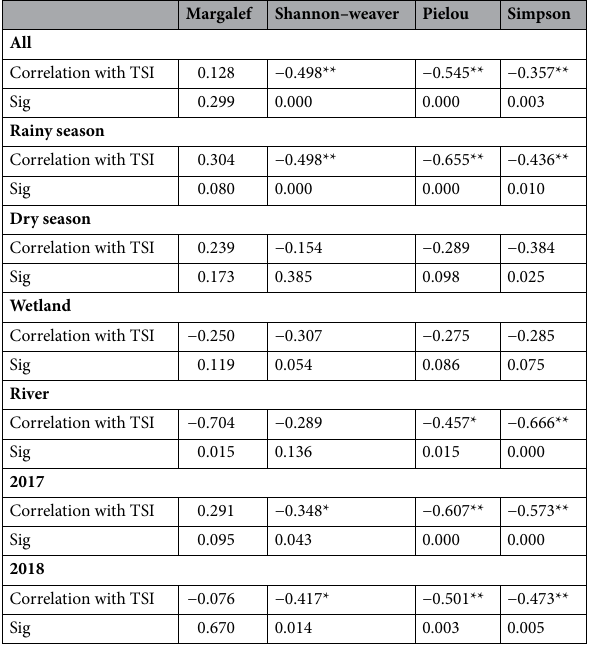
Table 4. The correlation coefficients found by correlation analysis of phytoplankton diversity indices and TSI in All samples, Wetland samples (S01–S10), River samples (S11–S17) in different hydro periods. *Denotes p < 0.05 (two-tailed), **Denotes p < 0.01